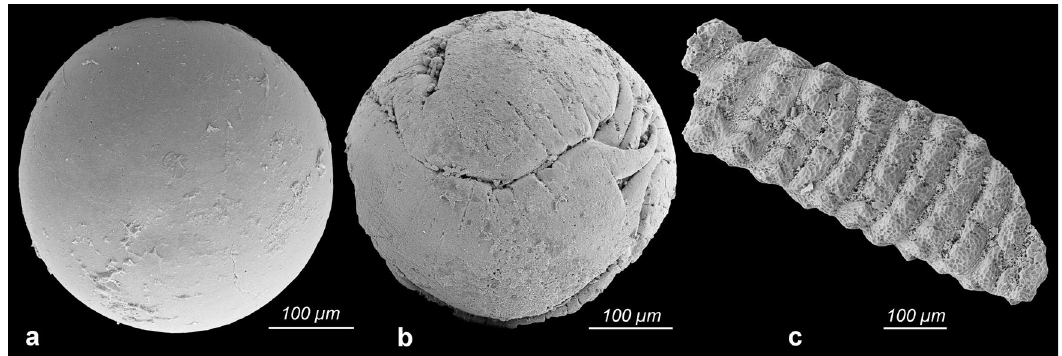
Fig. 2 Phosphatized soft-bodied and cuticularized eggs, embryos, and articulated postembryonic developmental stages of the new Orsten-type fossil lagerstätte Salanyi Gol (Mongolia). a Egg. b Late-stage embryo of Markuelia with six large posterior hooks. c Articulated, hitherto undescribed slug-like organism with rows of cuticularized humps with net-like ornaments. All images are electron microscope micrographs. Specimen identi fi ers: a Sal 134-38; b Sal 134-16; c Sal 134-28.